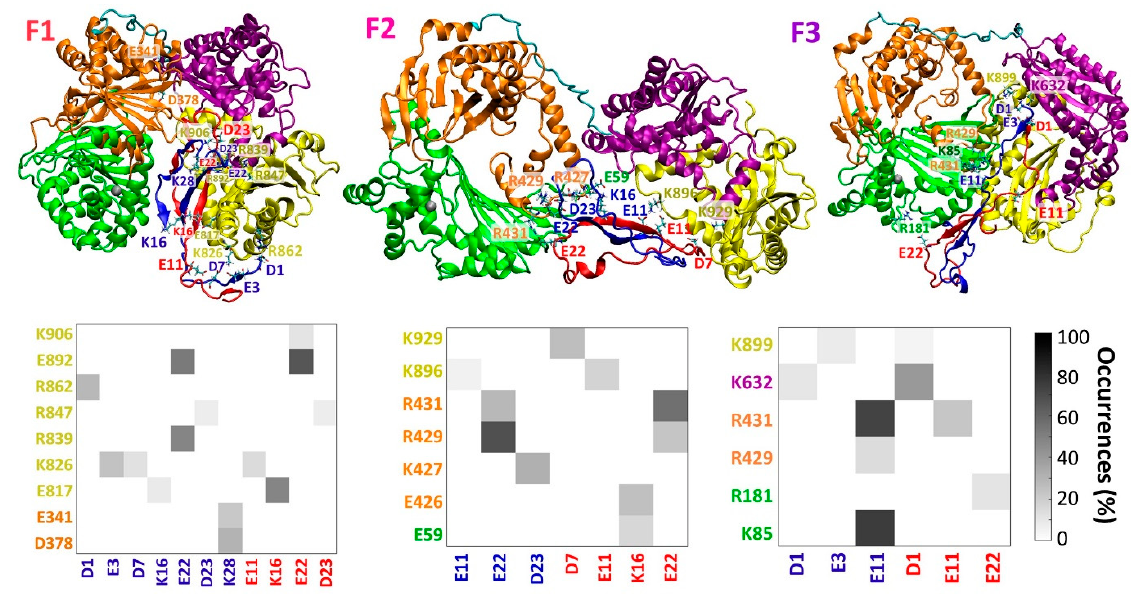
Figure 1. Top: Final simulated structures of IDE-A β fibril-like dimer of models F1 (left), F2 (center), and F3 (right). Bottom: Electrostatic interactions contact maps (measured by the occurrences in percentages along the MD simulations) between residues within the IDE domains (domain 1: green; domain 2: orange; domain 3: purple; domain 4: yellow) and A β monomers within the dimer for models F1 (left), F2 (center), and F3 (right).